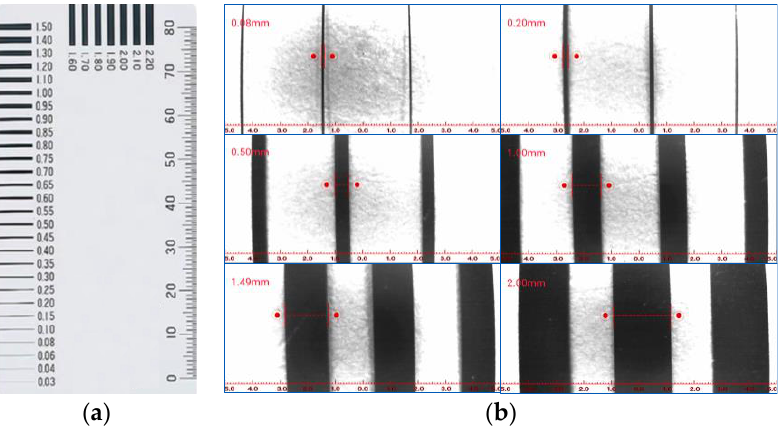
Figure 12. Accuracy verification results of the adopted crack width measuring instrument: ( a ) crack scale board with several standard widths; ( b ) measurement results for standard widths.